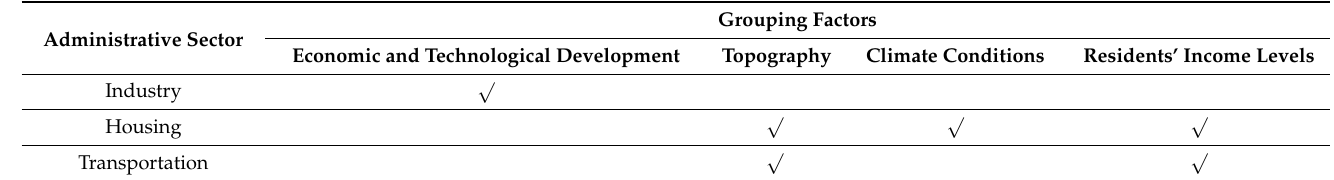
Table 2. Grouping factors for low-carbon management potential